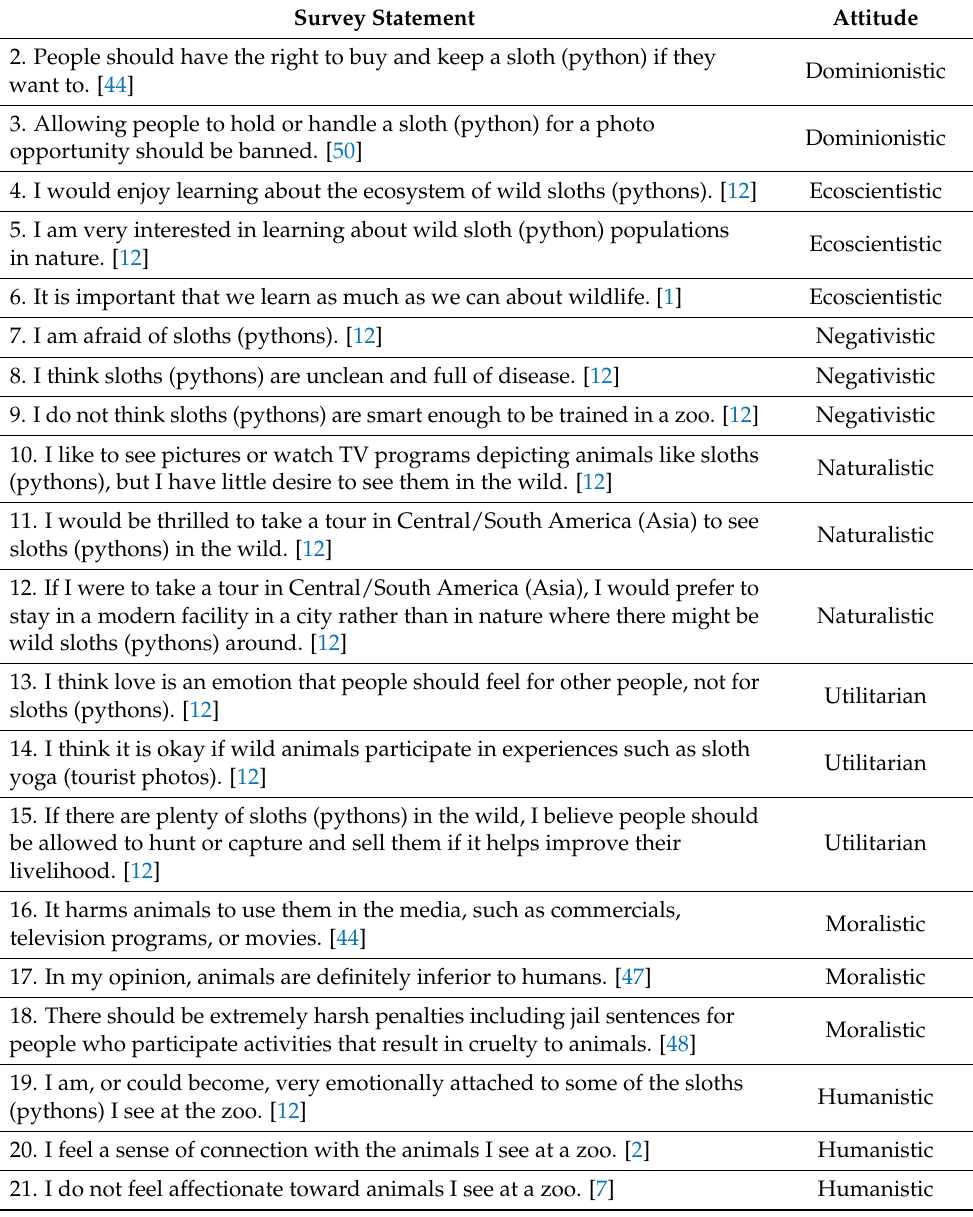
Table 1. Survey statements used in principal components analyses (PCA) and predicted attitude. Survey statement 1 was the subject of another study [26] and is not included below but can be found in Supplementary